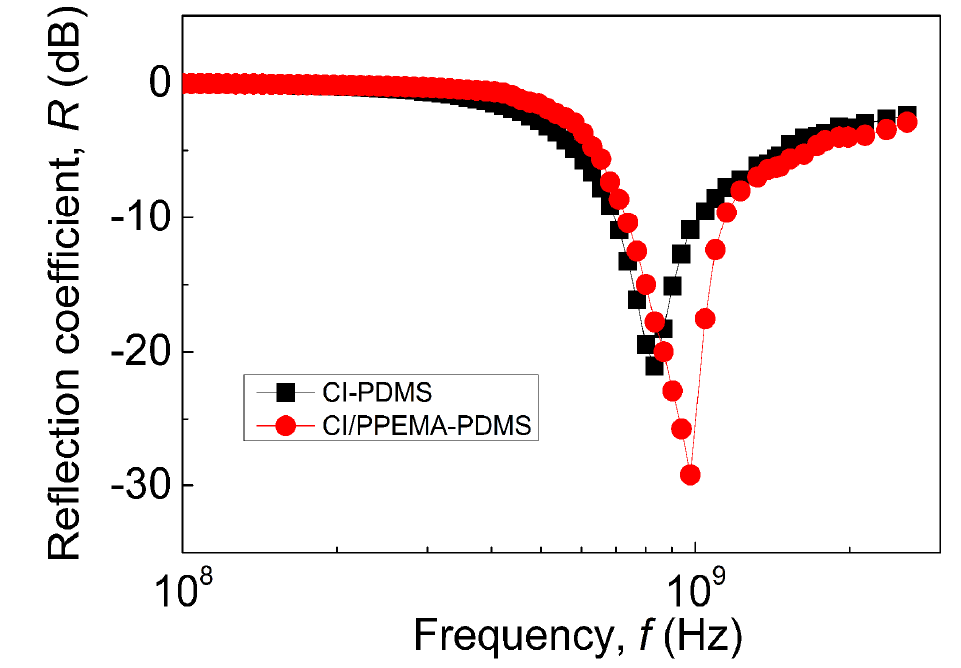
Figure 7. Electromagnetic shielding performance for neat CI based elastomers ( (cid:4) ) and CI-PPEMA based elastomers ( • ).